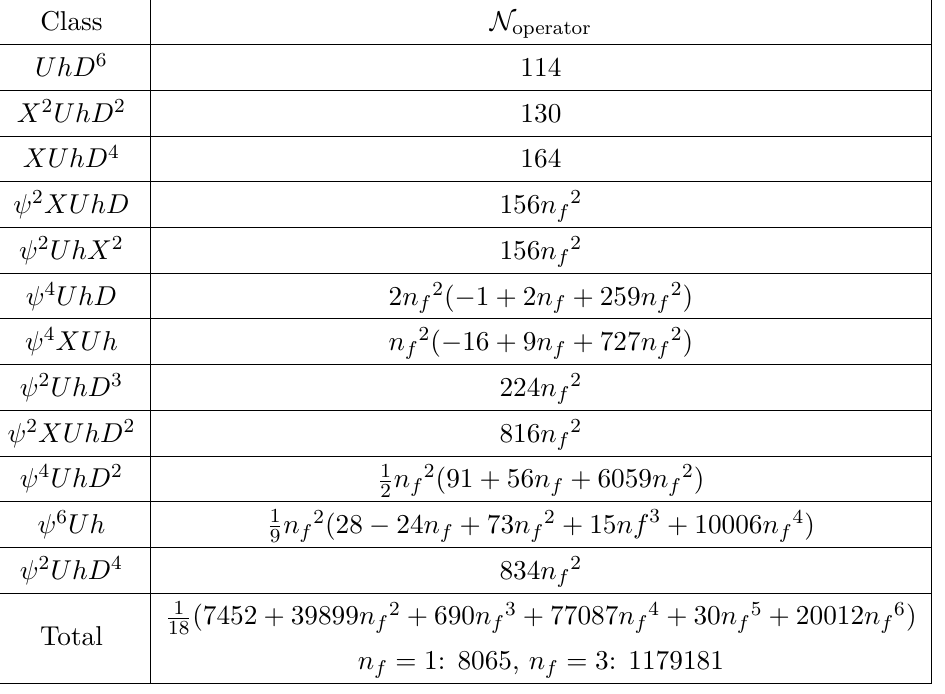
Table 4 . The numbers of the NNLO operators in each class without right-handed neutrino.